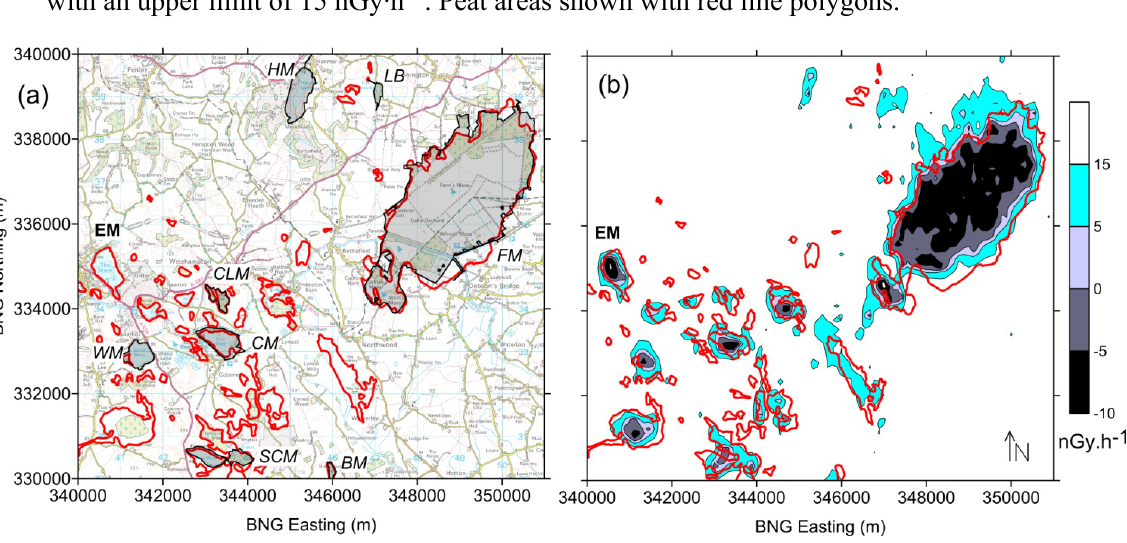
Figure 5. The 11 × 10 km study area from the northern Midlands survey. ( a ) 1:50 k base topographic map with peat areas shown with red line polygons. Areas with grey transparent infill denote eight Ramsar wetland sites. Sites identified are: FM = Fenn’s and other Mosses, HM = Hanmer Mere (non-peat), LB = Llyn Bedydd (non-peat), WM = White Mere (largely non-peat), CLM = Clarepool Moss, CM = Cole Mere, SCM = Sweat and Crose Mere, BM = Brownheath Mere. Note that Ellesmere Mere (EM, non-Ramsar) is largely water. ( b ) Radiometric DOSE response across the area, shown as coloured contours with an upper limit of 15 nGy·h − 1 . Peat areas shown with red line